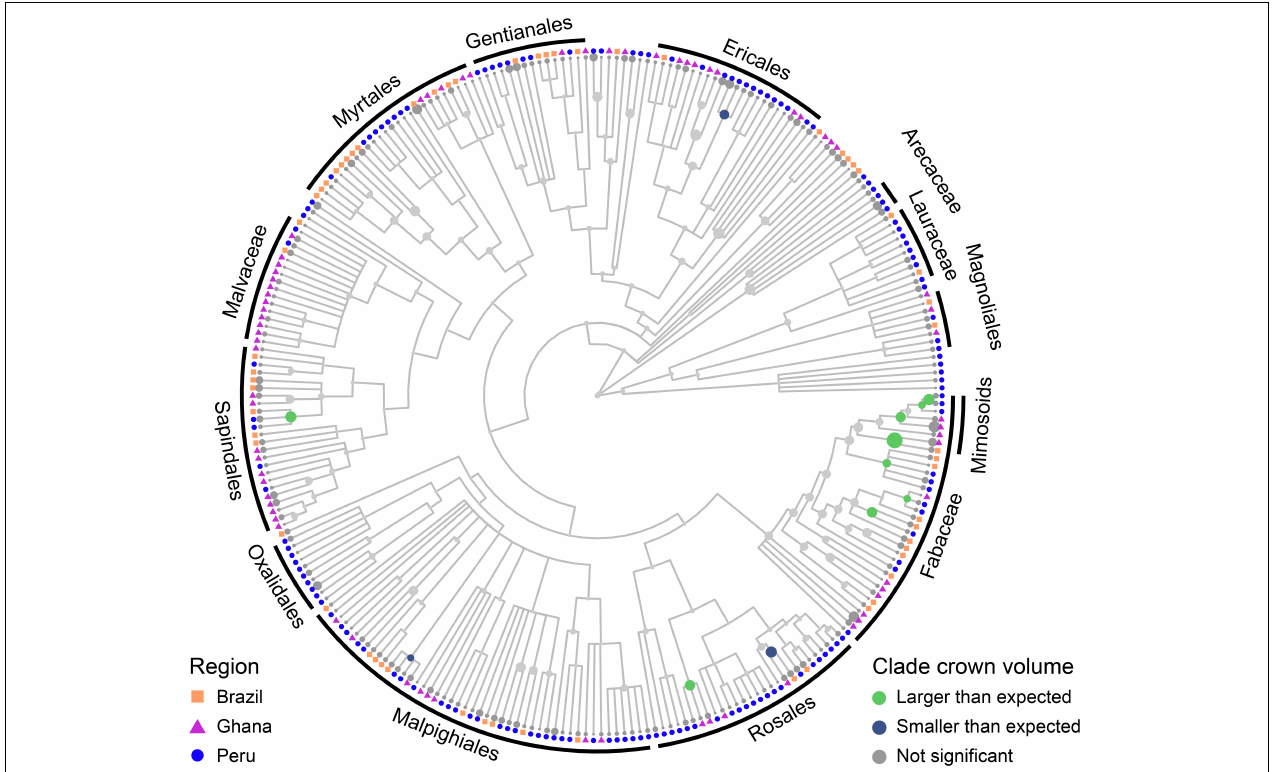
FIGURE 4 | Mean per-species residuals from the crown volume vs. stem radius scaling LMM with species as a random effect mapped onto a tree species phylogeny (see section “Materials and Methods” for details of phylogeny construction). A residual in this instance implies a difference in intercept, not slope, in the model. Size of circle corresponds to size of residual. Internal node states were determined using fastANC (see section “Materials and Methods”), with colors indicating direction and confidence of internal node estimates: 95% confidence interval of model residuals of gray nodes intersects zero, green nodes indicate clades with larger than expected crowns, and blue nodes clades with smaller than expected crowns. Tips are not evaluated for significance and are therefore not colored. Similar plots with species names are included in Supplementary Figures S22–S25